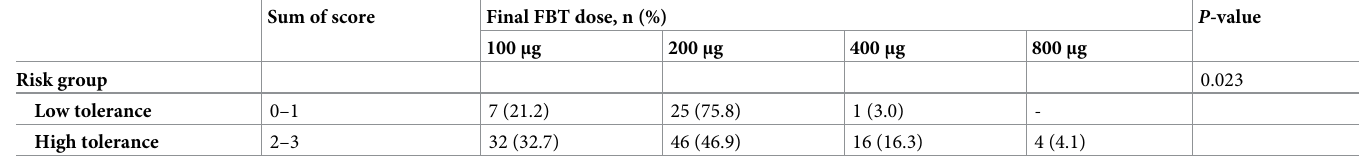
Table 4. Final fentanyl buccal tablet (FBT) dose according to risk scores based on odds ratio (OR) from the final multivariate model. Sum of score Final FBT dose, n (%) P